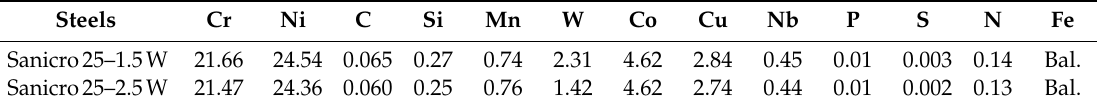
Table 3. Chemical compositions in weight % (wt.%) of two Sanicro 25 steels. Steels